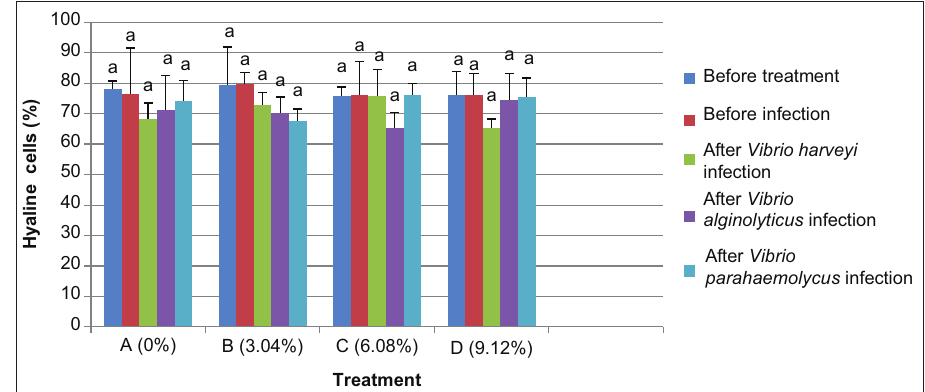
Figure-1: The number of hyaline cells of vannamei shrimp ( Litopenaeus vannamei ) before and after infected with Vibrio harveyi, Vibrio alginolyticus, and Vibrio parahaemolyticus and treatment with Majapahit ( Crescentia cujete L.) fruit powder. Data were indicated as mean value±SD. Graphs with different notations showed significantly different